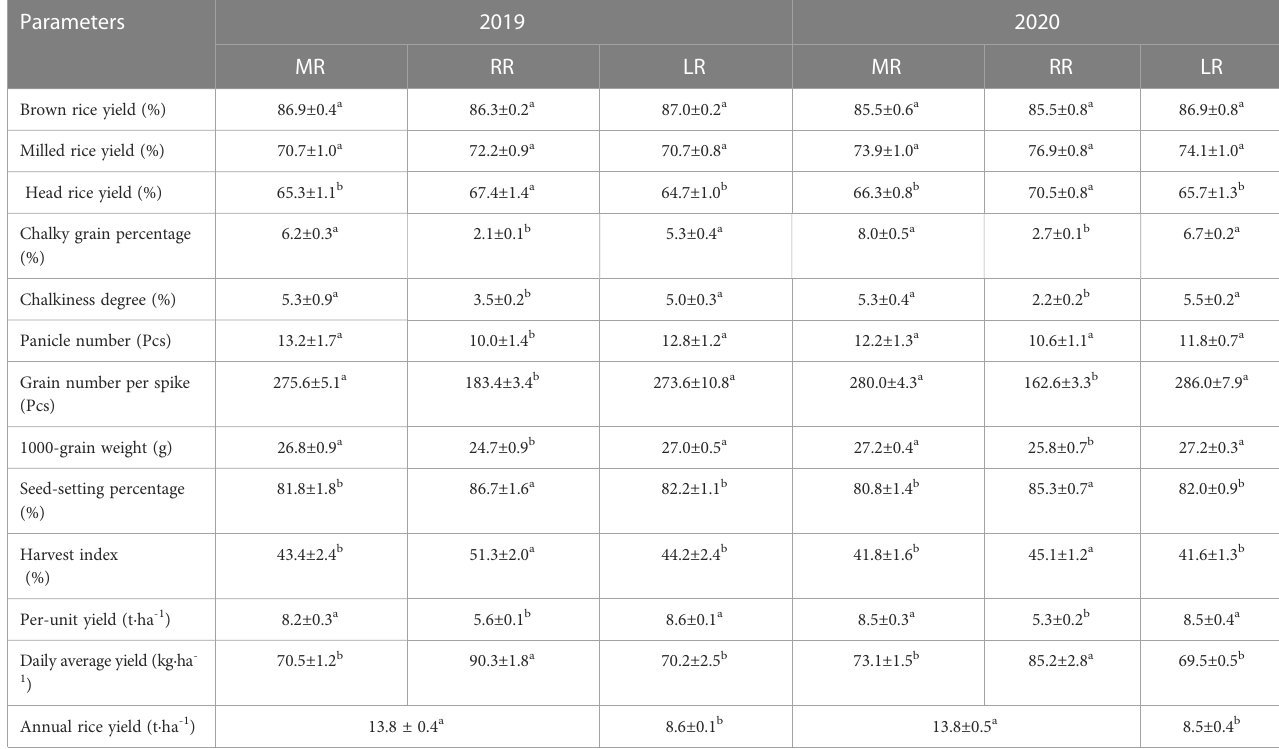
TABLE 2 Comparison of grain quality and yield performance between early-season rice, ratoon rice, and late-season rice.